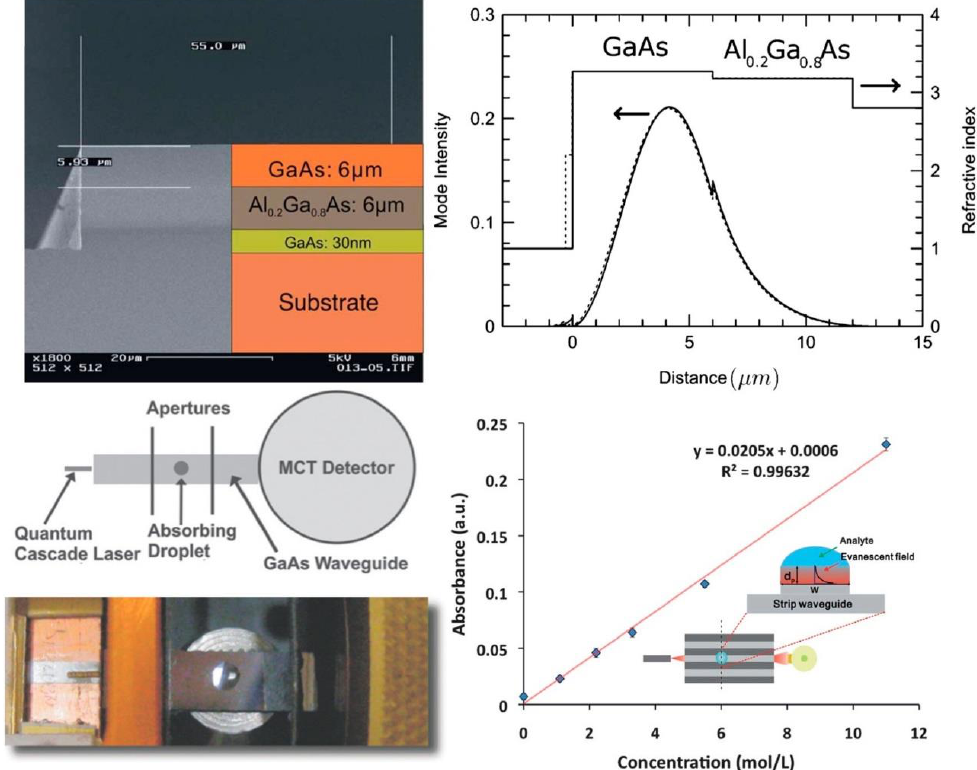
Figure 5. ( top left ) Cross-section of a MOVPE-grown GaAs/Al 0.2 Ga 0.8 As ridge waveguide obtained via reactive ion etching. ( top right ) Computed optical mode profile of the thin-film GaAs/AlGaAs waveguide structure with a layer dimension of 6 µ m (left axis, mode intensity; right axis, refractive index). ( bottom left ) Experimental setup of a single wavelength emitting QCL pigtail-coupled to a GaAs slab waveguide. ( bottom right ) Analytical response to 2-nL droplets of an analyte in evanescent field absorption measurement with QCL pigtail-coupled to a structured GaAs ridge waveguide (200 µ m in width). Reproduced with permission from ref. [12]. Copyright 2006 the American Chemical Society. Reproduced with permission from ref. [87]. Copyright 2012 the Royal Society of